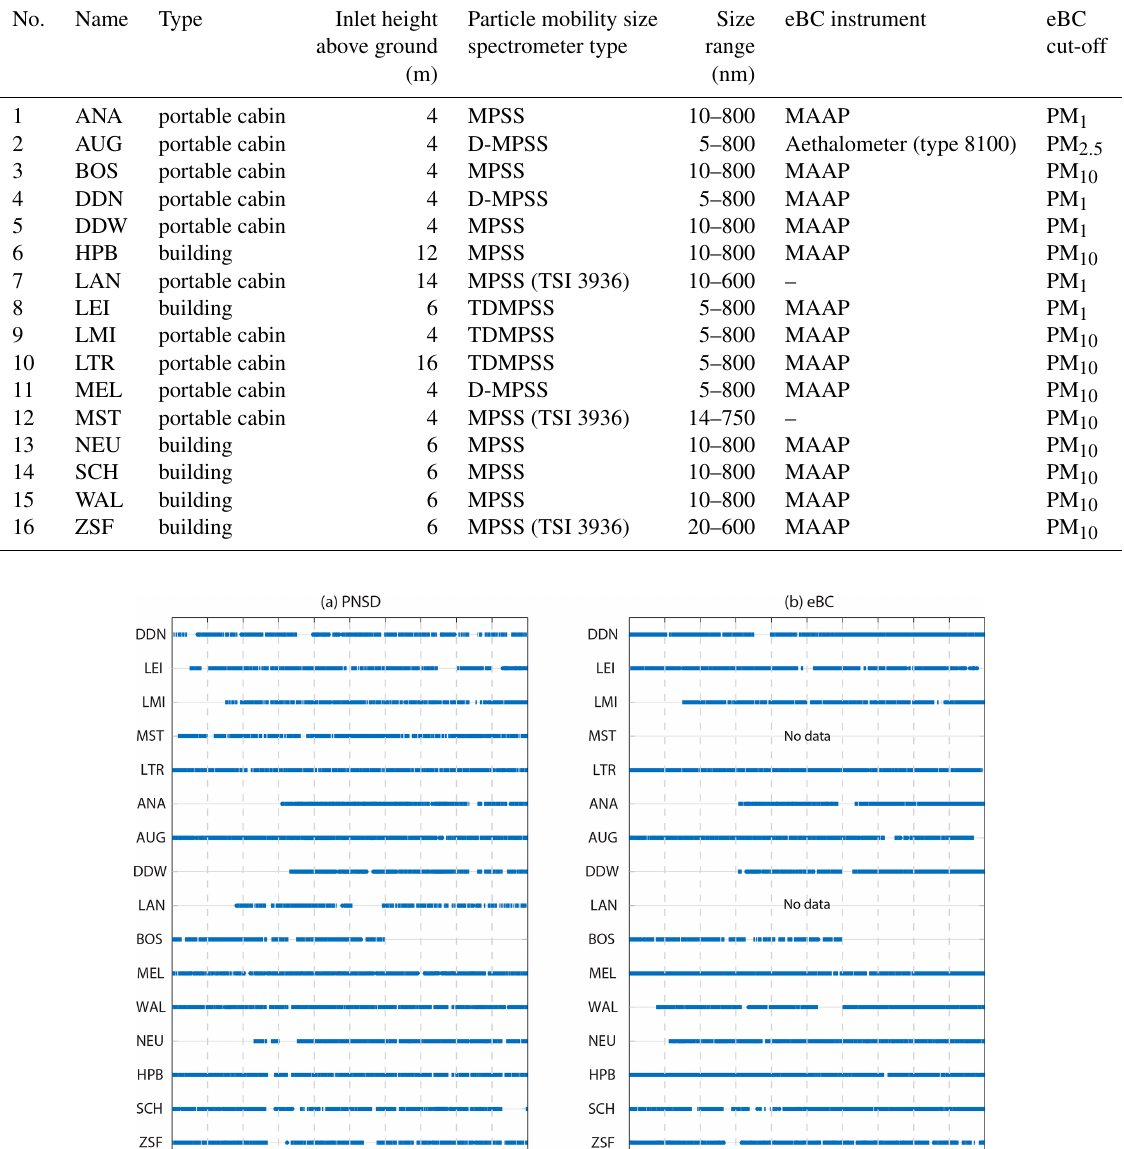
Table 2. Technical details of the instrumentations of the 16 GUAN sites.